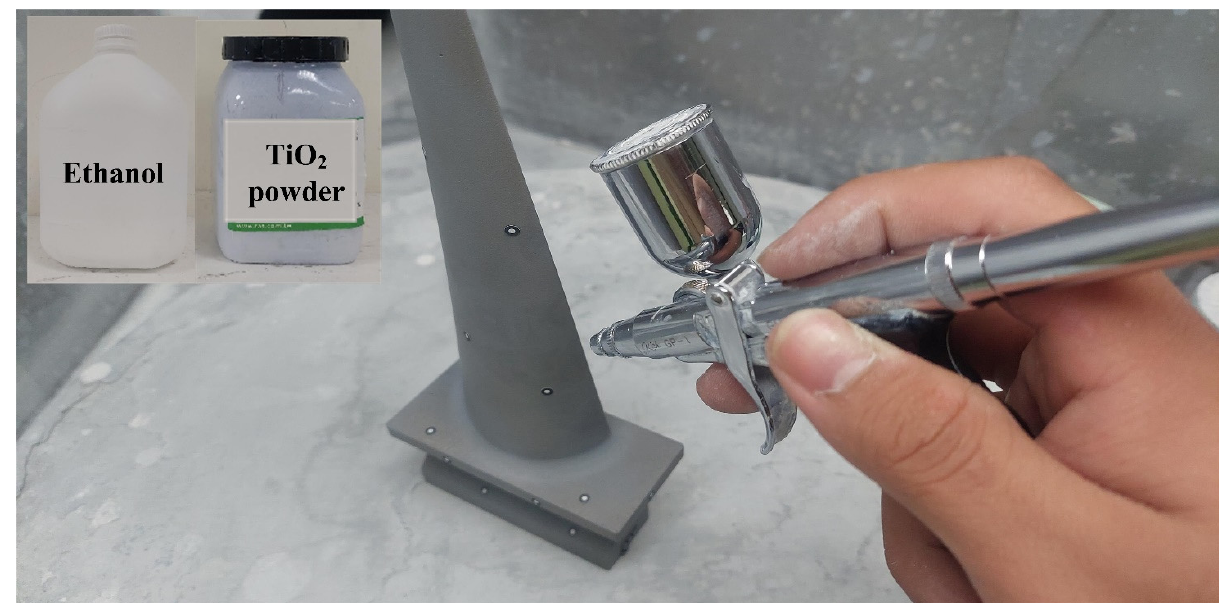
Figure 4. Situation of object sprayed with mixture of TiO 2 powder and ethanol.